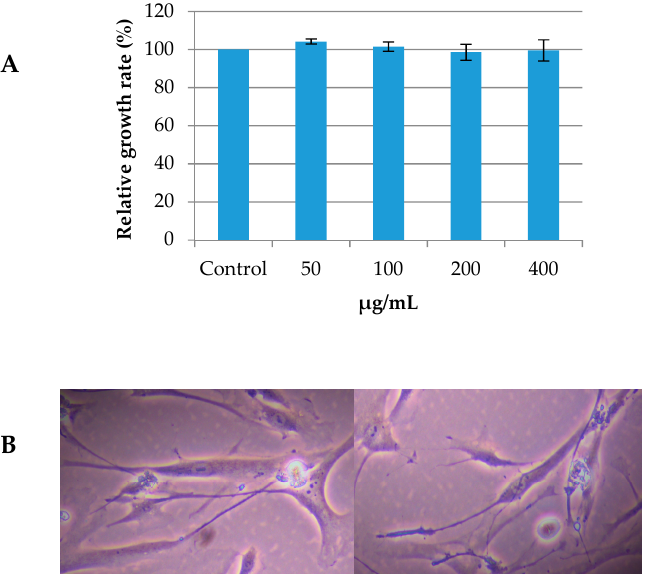
Figure 4. ( A ) Relative growth rate (%) of human gingival fibroblast (HGF-1) cells treated with different concentrations of O. spinosa extract showing no statistical difference between treatments ( p < 0.05); ( B ) representative phase contrast image of non-treated control cells and ( C ) representative phase contrast image of cells treated with O. spinosa extract (400 µg/mL).